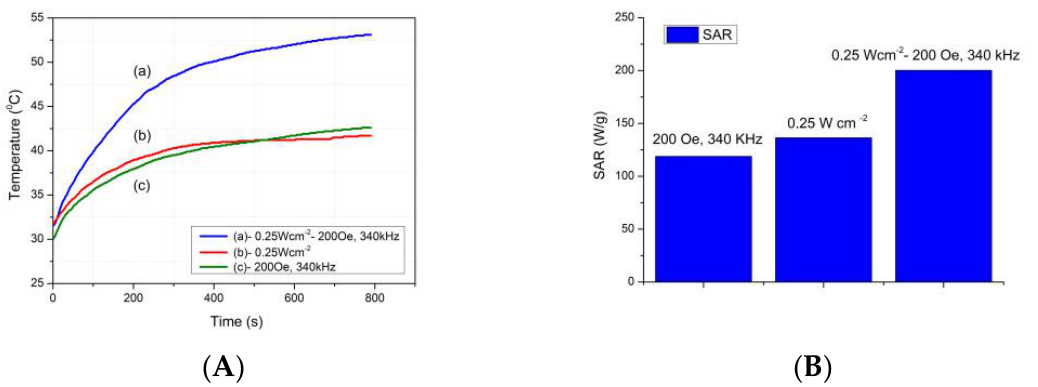
Figure 11. ( A ) Heating curves of the FOASET nanoparticles with (a) MT, (b) PT, and (c) MPT modes; ( B ) SAR calculations of the FOASET nanoparticles with different heating modes.